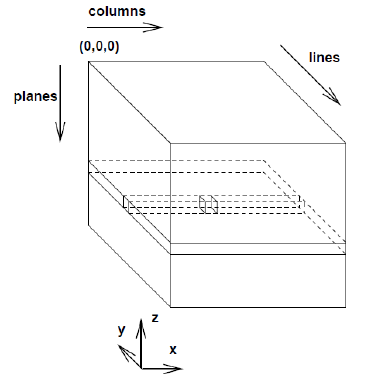
Figure 5: Voxel space with (x,y,z) coordinate system (Gorte and